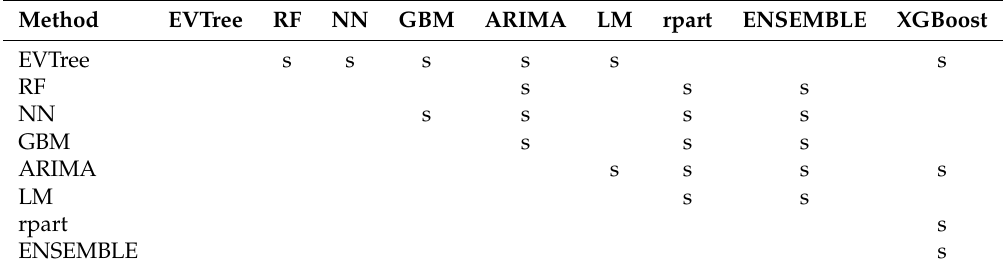
Table 6. Significance of the results regarding MAE according to two-tailed t -test with confidence level of 1%.